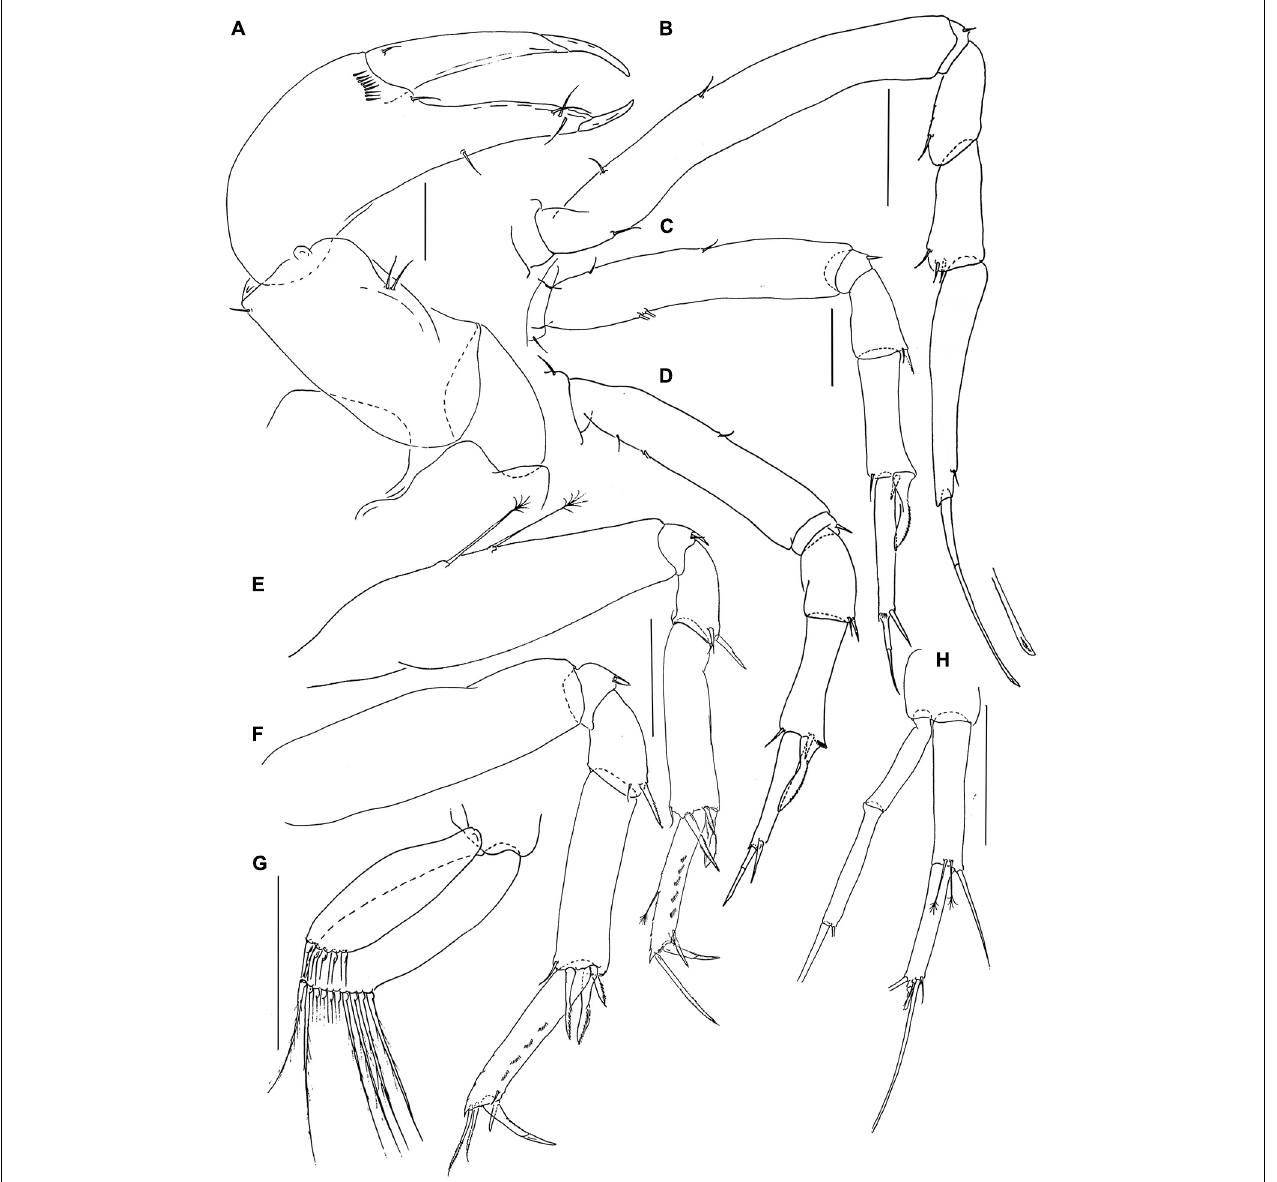
FIGURE 5 | Pseudotanais caberneti sp. nov.; female (J62735), (A) , cheliped; (B) , pereopod-1; (C) , pereopod-2, (D) , pereopod-3; (E) , pereopod-4; (F) , pereopod-6; (G) , pleopod; (H) , uropod. Scale lines = 0.1 mm.